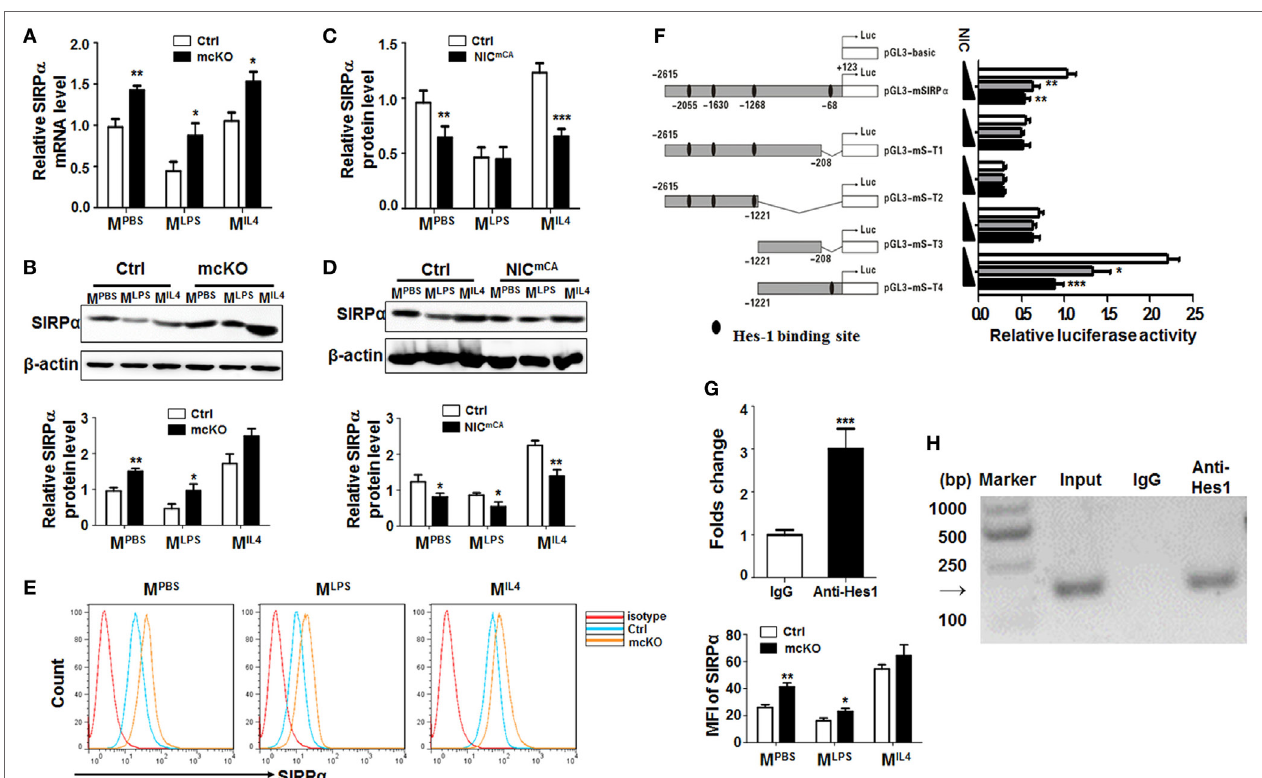
FigUre 1 | Notch signal regulated Signal regulatory protein α (SIRP α ) expression in macrophage polarization. (a,B) Bone marrow-derived macrophages (BMDMs) from RBP-J knock out (mcKO) and control (Ctrl) mice were stimulated with PBS, LPS + IFN γ , or IL4 for 24 h. The expression of SIRP α was determined